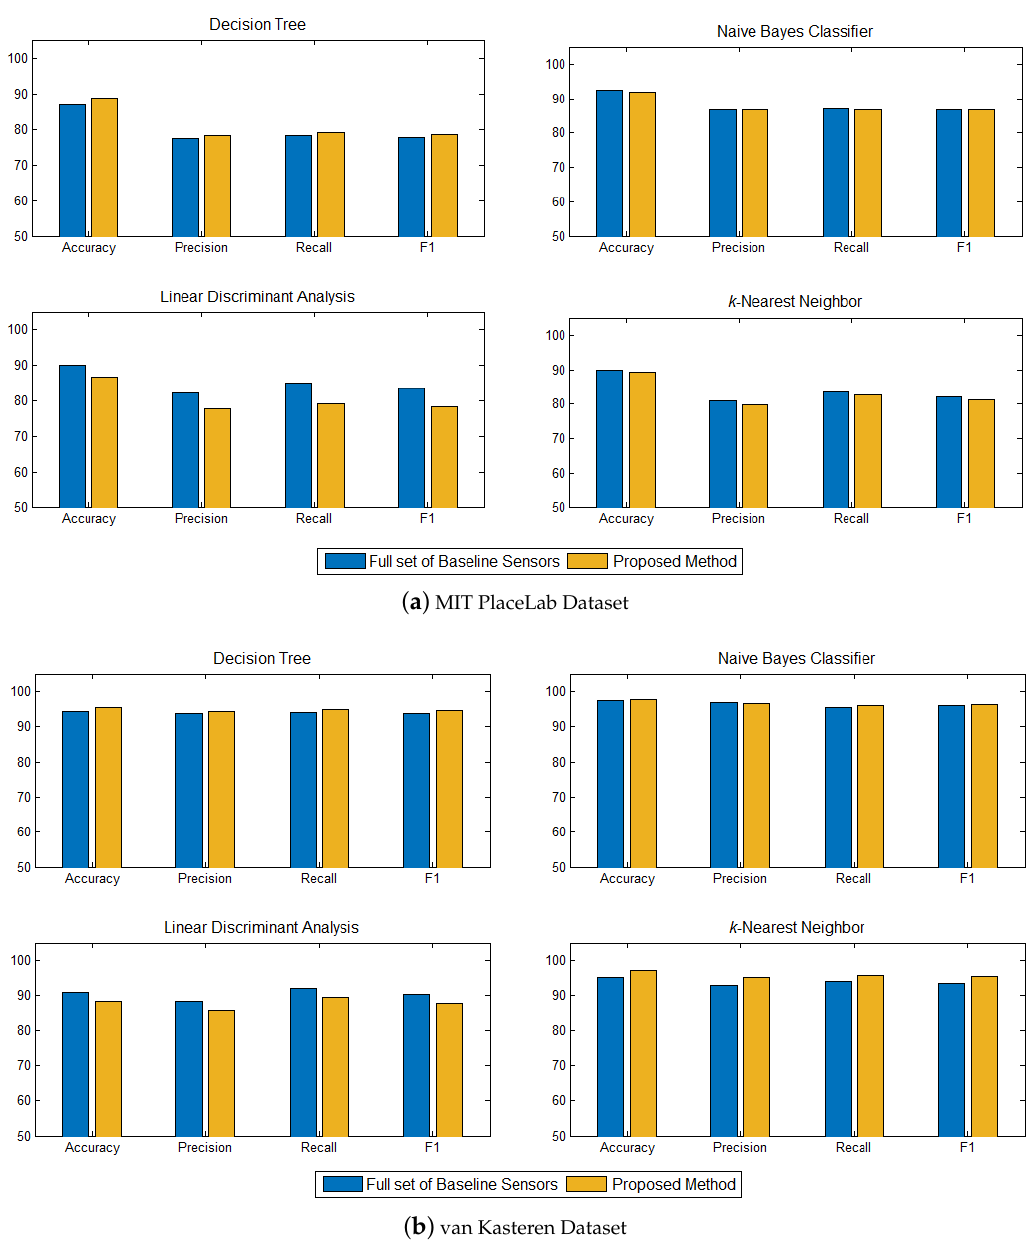
Figure 7. Average recognition performance of the proposed method with the full set of baseline sensors for ( a ) MIT PlaceLab dataset and ( b ) van Kasterenn dataset on four classifiers—decision tree, naïve Bayes classifier, linear discriminant analysis and k -nearest